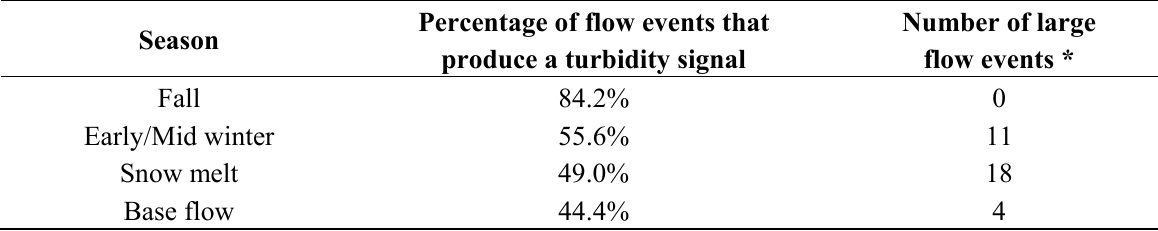
Table 3. Percentage of flow events producing turbidity and number of flow events by season for all catchments.